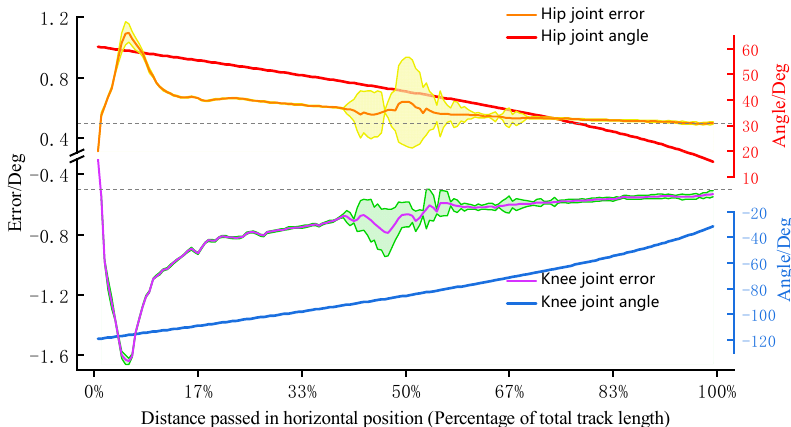
Figure 8. Joint tracking performance.